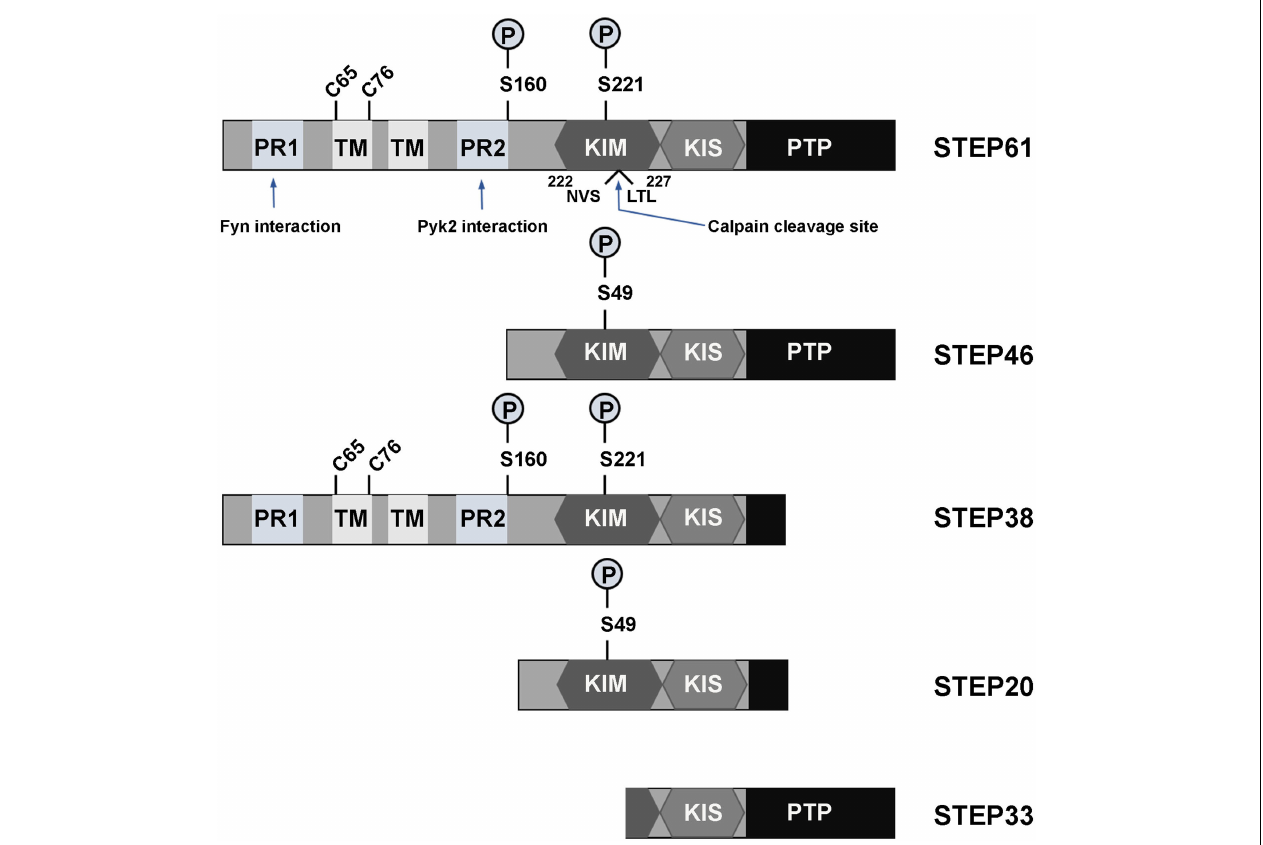
FIGURE 1 | Isoforms and domains structure of STEP. The alternative splicing of PTPN5 gene results in the production of four STEP isoforms (STEP61, STEP46, STEP38, and STEP20), while the fifth STEP isoform, STEP33, is the result of calpain cleavage of STEP61 at Ser224/Leu225 site. STEP61 and STEP46 are the fully active and major STEP proteins in the CNS. These two isoforms contain the KIM, KIS and PTP domains, which are respectively required for substrate interaction, specificity and phosphatase activity. STEP61 has two additional TM domains that serve for targeting it to the ER and PSD, as well as two PR (PR1 and PR2) regions that specifically provide binding with Fyn and Pyk2, respectively. The activity of STEP is inhibited via PKA phosphorylation at Ser221 and Ser49 within the KIM domain for STEP61 and STEP46, respectively. PKA can also phosphorylate STEP at Ser160 around the PR2 region, but its function is still unknown. The function of STEP can also be decreased by dimerization of STEP molecules via the C65 and C76 present within the TM domain. Together with STEP33 (the isoform that has disrupted binding domain), STEP38 and STEP20 are inactive variants since they have no PTP domain and thus lack phosphatase activity. Therefore, it is speculated that they may serve as negative regulators of STEP substrates by competitive binding. Adapted from Lombroso et al.